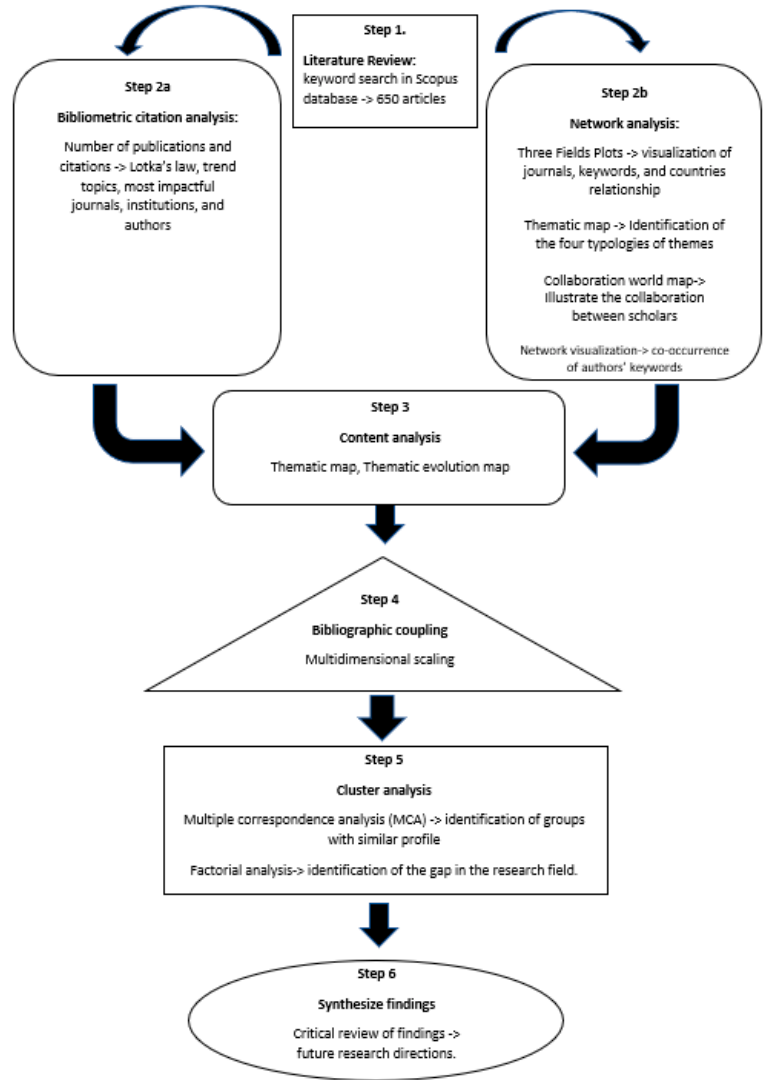
Figure 3. Methodological workflow for bibliometric analysis.